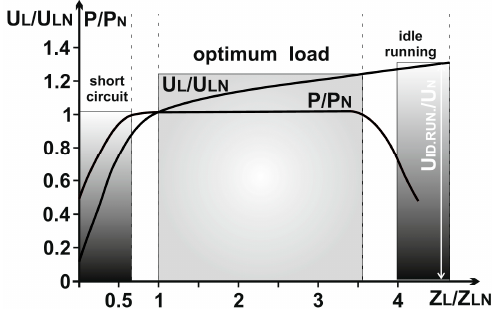
Figure 10. Load characteristic of AI with ED.